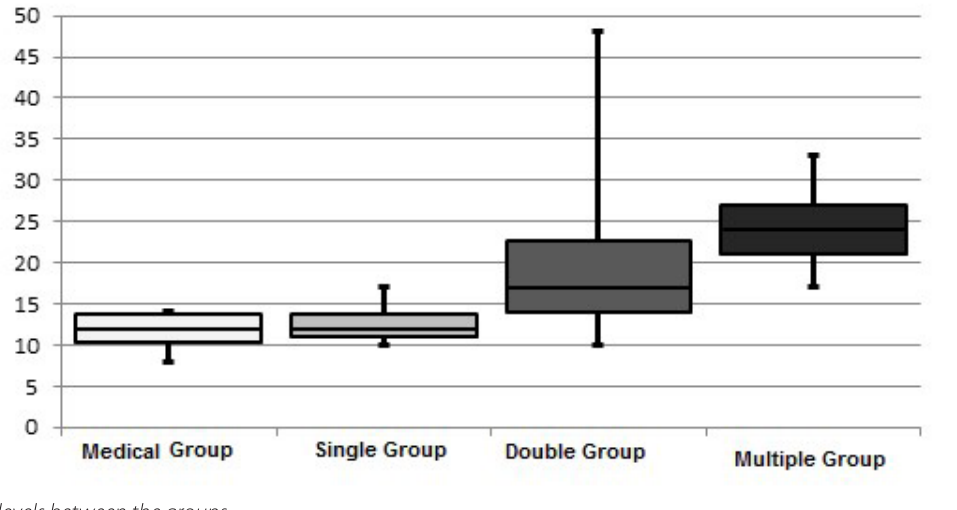
Fig. 1 - Asprosin levels between the